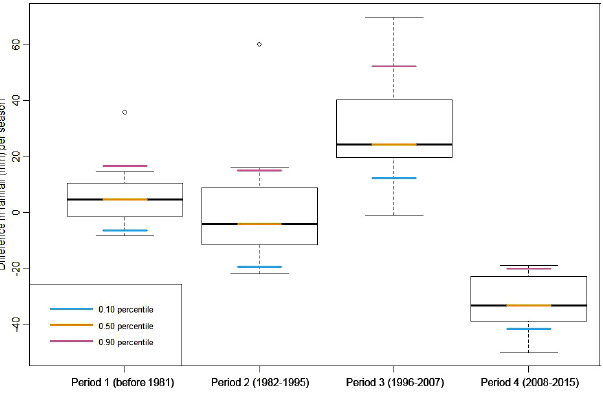
Fig. 3 . Differences in rainfall between Old and New Seasons across the research area (see Box A3.1 in Appendix 3). Positive difference indicates more rainfall in Old Season (March–May) and negative difference indicates more rainfall in New Season (April–June) during each period. Boxes indicate 25 and 75 percentiles, whiskers 5 and 95 percentiles. Differences are highly significant between P2, P3, and P4 (p < 0.01). Note pronounced variability in P3 and shift to more rainfall in the New Season in P4, after